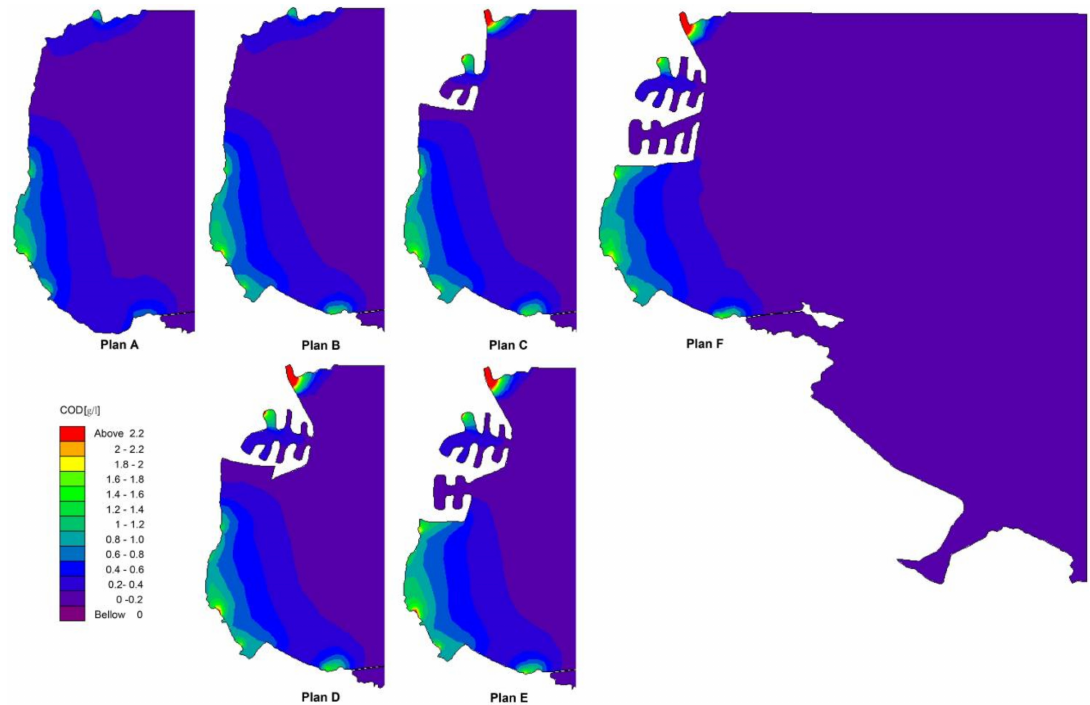
Figure 6. The COD response fields for 12 pollution sources (scenario 3). The COD response field in plan A; the COD response field in plan B; the COD response field in plan C; the COD response field in plan D; the COD response field in plan E; the COD response field in plan